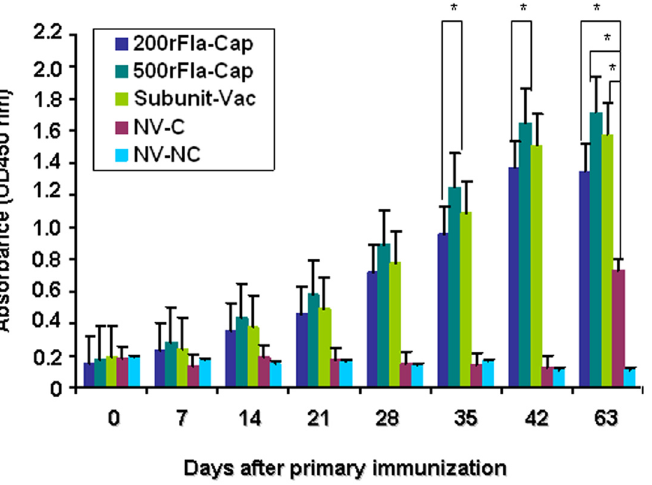
Fig 1. Kinetics of mean PCV2 Cap-specific antibodies in pigs vaccinated with rFla-Cap protein after vaccination and PCV2 challenge using an ELISA method. Results indicate mean absorbance values of serum samples for each group ± SD from one of two independent experiments. p < 0.05 ( * ) represents significant difference between 500rFla-Cap and 200rFla-Cap-vaccinated pigs at the indicated times after vaccination, or vaccinated and non-vaccinated pigs after PCV2 challenge (day 63).